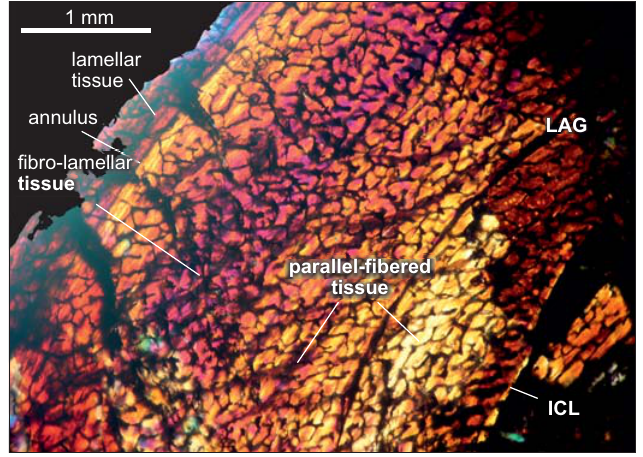
Fig. 5. Femur of archosauromorph Chanaresuchus bonapartei Romer, 1971 (PULR-V 125, in lambda light) from La Rioja province, NW Argentina; Chañares Formation, Carnian (Late Triassic). Section showing the main features of the femur bone microstructure. Abbre viations: ICL, Inner Circumferential Layer; LAG, line of arrestred